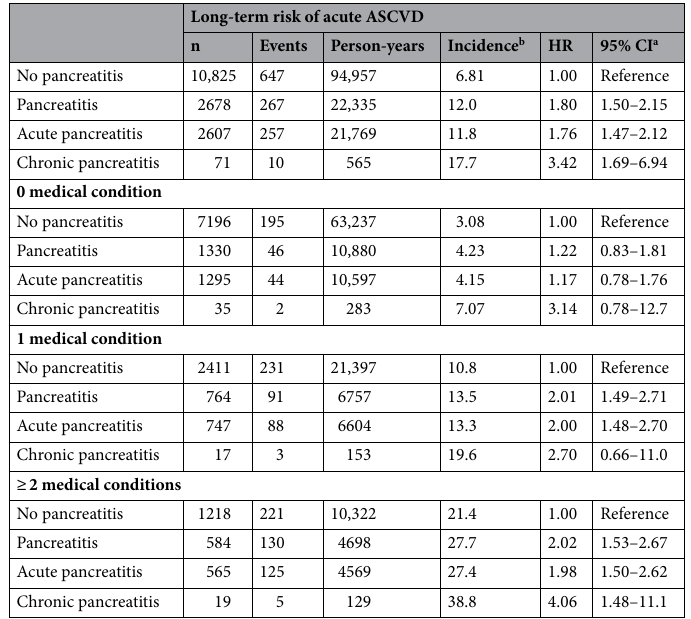
Table 2. The long-term risk of acute ASCVD for people with and without pancreatitis. ASCVD atherosclerotic cardiovascular disease, CI confidence interval, HR hazard ratio. a Adjusted for all covariates listed in Table 1. b Per 1000 person-years.